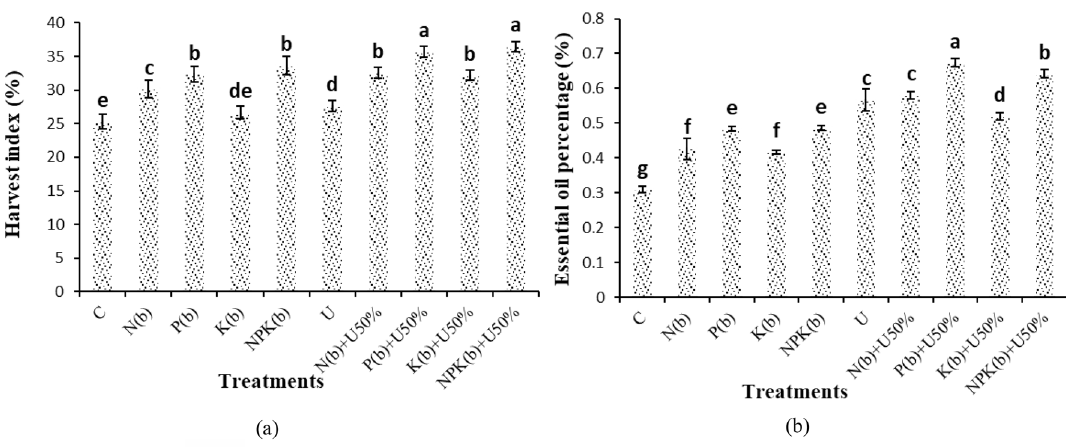
Figure 4. Means comparison for Essential oil percentage and Harvest index per ha of Nigella sativa L. as influenced by biofertilizers and urea. Dissimilar letters show significant differences at the p < 0.01 level. Control (C), U Chemical urea, Nb (biological N), Pb (biological P), Kb (biological K, NPKb (mixed biological NPK), Nb + U50%, Pb + U50%, Kb + U50%, and NPKb +